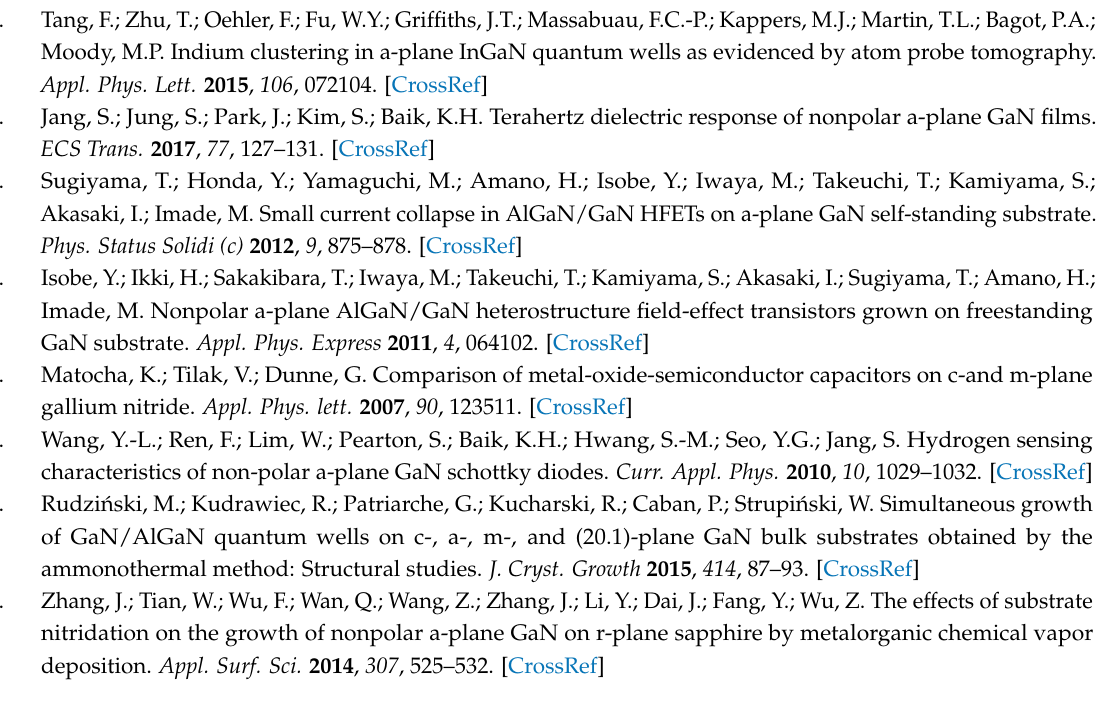
Figure S1: Plan-view SEM image of a-plane GaN nanodots formed on r-plane sapphire substrate after in situ surface treatment. Figure S2: Barrier height and ideality factor versus temperature in Au/HVPE a-plane GaN templates formed by in situ nanodot formation based on TFE